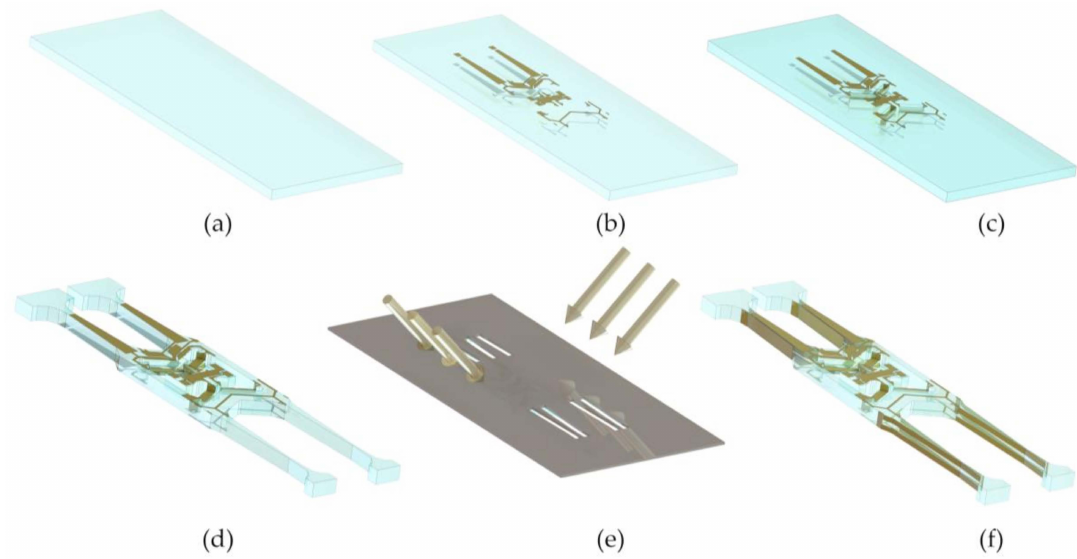
Figure 4. The fabrication process of micro quartz tuning forks gyroscope. ( a ) Z-cut quartz crystal